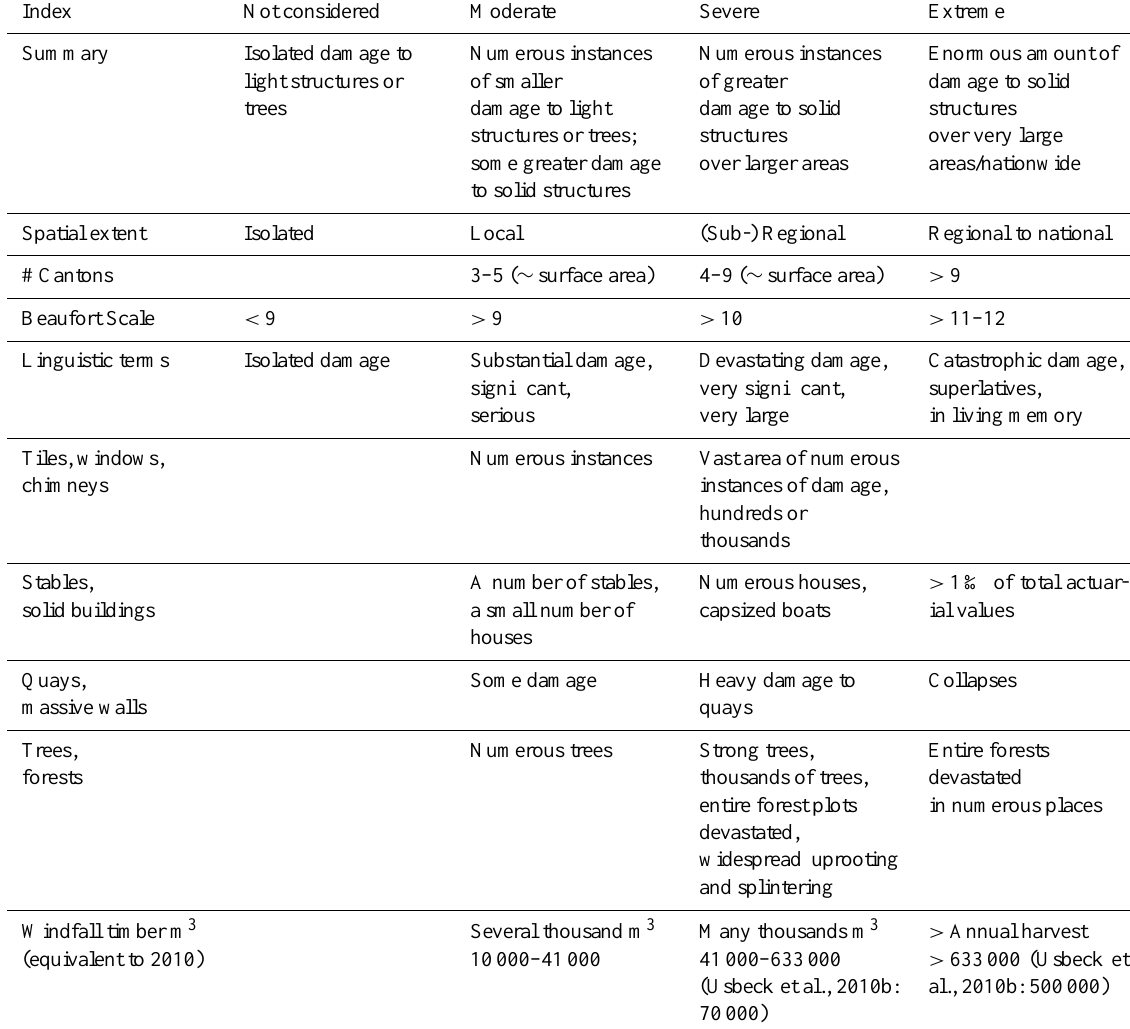
Table 2. Conceptual guideline for indexing of windstorm